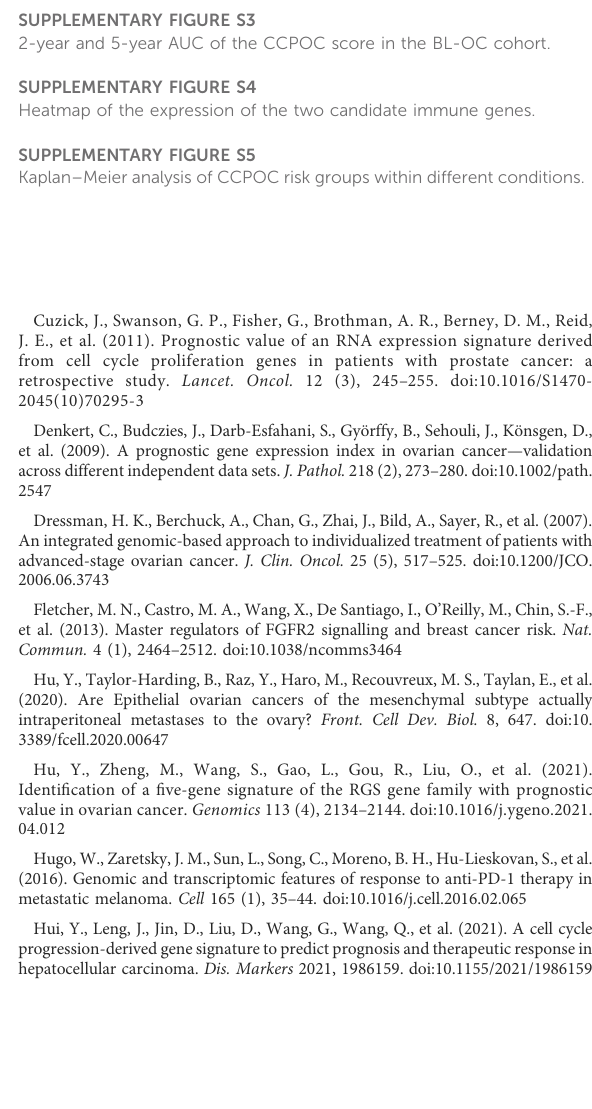
SUPPLEMENTARY FIGURE S1 Kaplan – Meier analysis of different molecular subtypes. SUPPLEMENTARY FIGURE S2 Expression levels of POLA2 and KIF20B (B) genes among different subtypes.